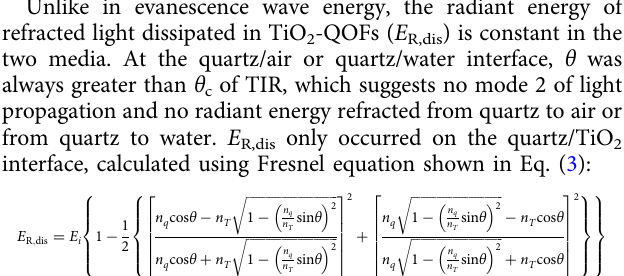
where n q and n T are refractive indexes of quartz and TiO 2 ,